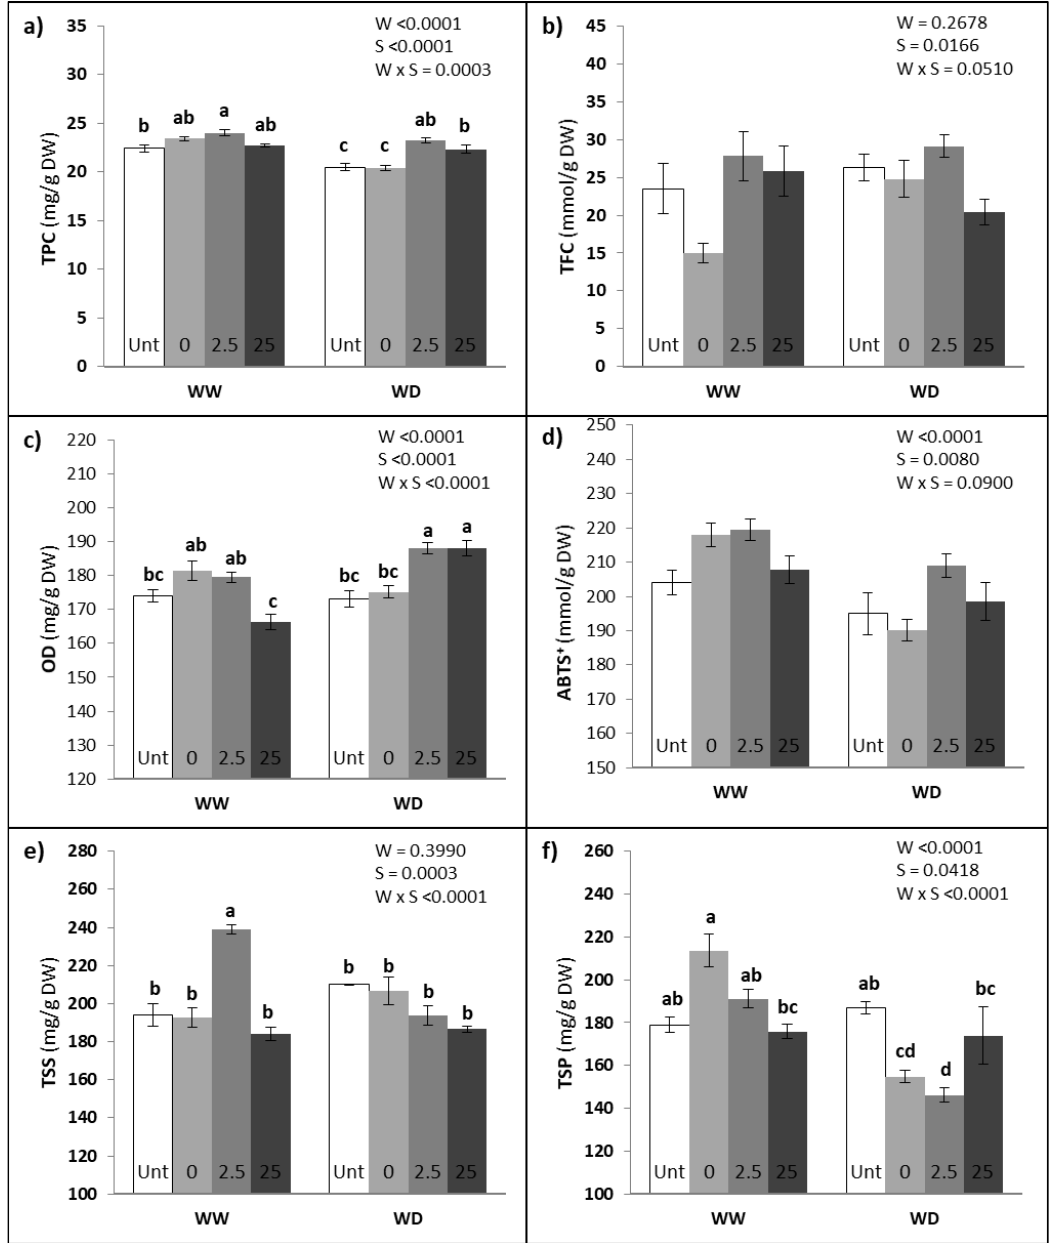
Figure 7. Total phenols—TPC ( a ); total flavonoids—TFC ( b ); ortho-diphenols—OD ( c ); ABTS + ( d ); total soluble sugars—TSS ( e ) and total soluble proteins—TSP ( f ); among two water regimes and four soaking treatments (untreated, 0, 2.5, and 25 mM). Values are means ± SE of DW ( n = 12). Different letters indicate statistically significant differences ( p < 0.05).